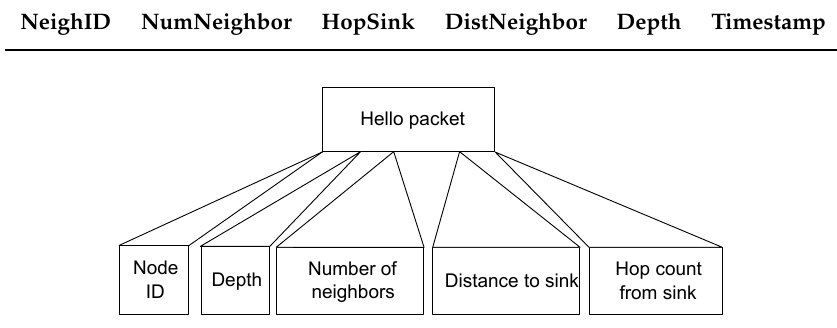
Figure 2. Hello packet